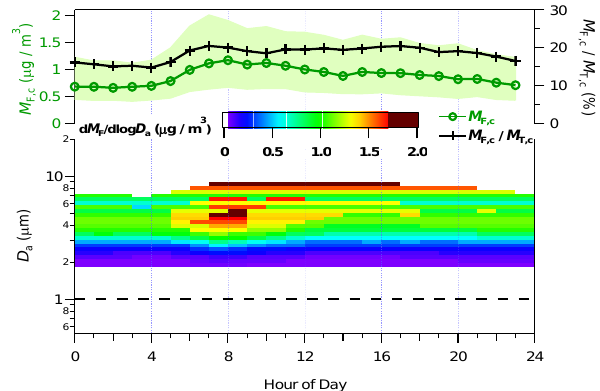
Fig. 6. Diel cycles of FBAP mass concentrations and size distribu- tions for the entire measurement period (hourly median values vs. local time of day). (a) Integrated coarse FBAP concentration (1– 20µm, M F , c ) on left axis (green) and FBAP fraction of TAP mass ( M F , c / M T , c ) on right axis (black). (b) FBAP mass size distribution with hour of day on x-axis, aerodynamic diameter on y-axis, and color scale of d M F /dlog D a with white values set to 0.04µgm − 3 for visual clarity. Dashed black line at 1.0µm shows particle size cut- off below which particles were not considered FBAP due to inter- ference with non-biological aerosol. Light-green shaded area shows FBAP concentration variability as the area between 25th–75th per- centile traces. Sharp cut-off in mass concentration above 10.5µm is due to counting statistics and use of median values in this plot (i.e., above this size more than 50% of 5L sample volumes contained no